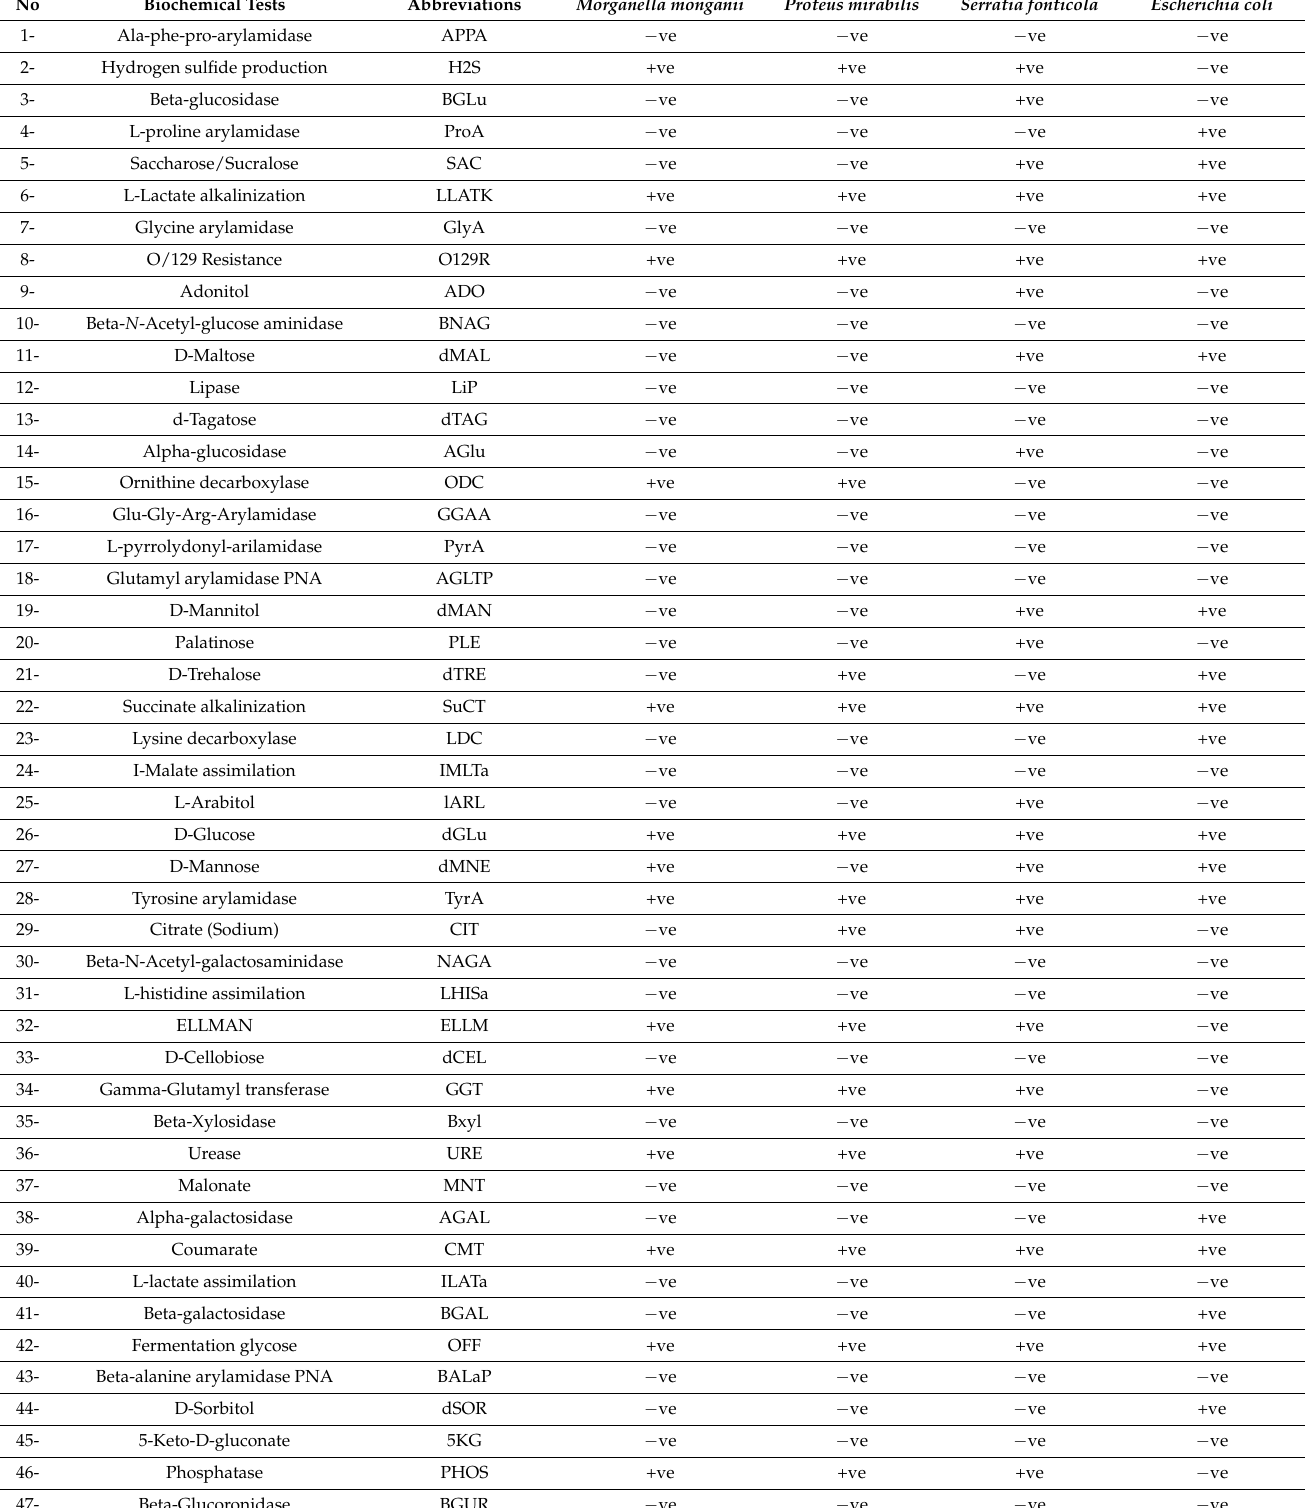
Table 1. Selection and Identification of antibiotic-resistant